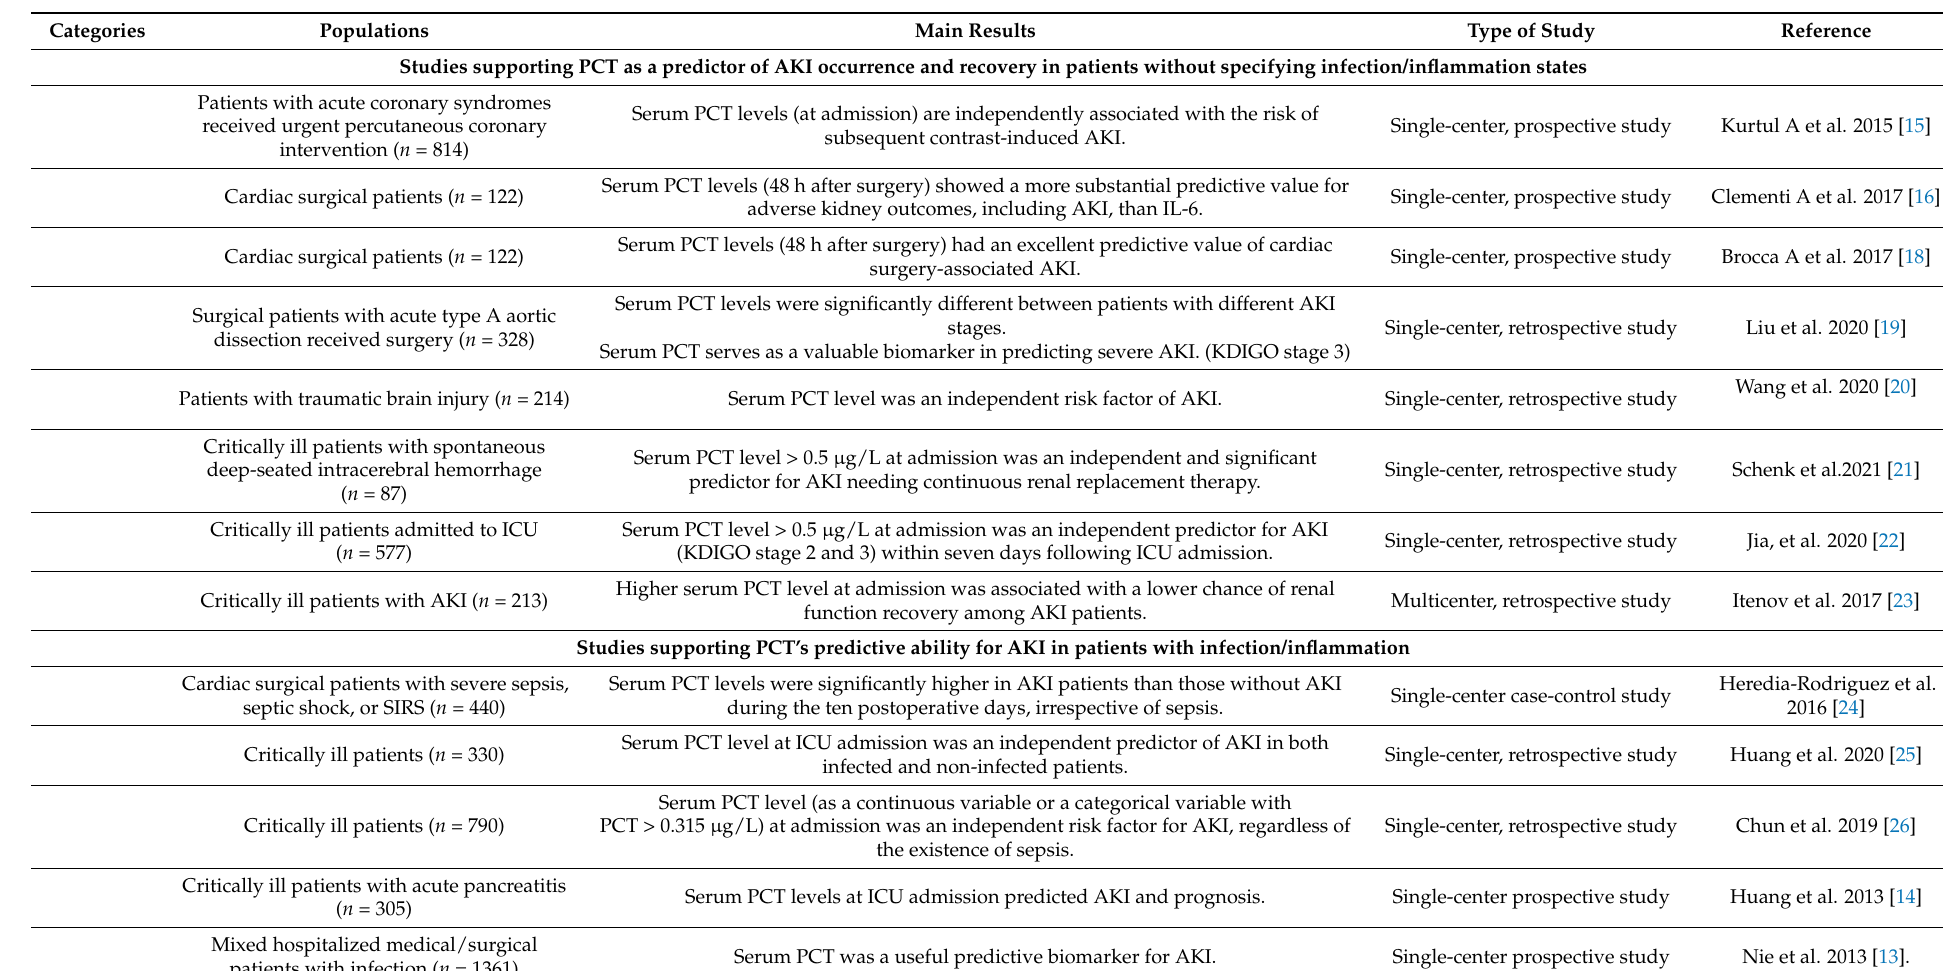
Table 1. Studies evaluating PCT’s predictive ability for AKI and the inference of